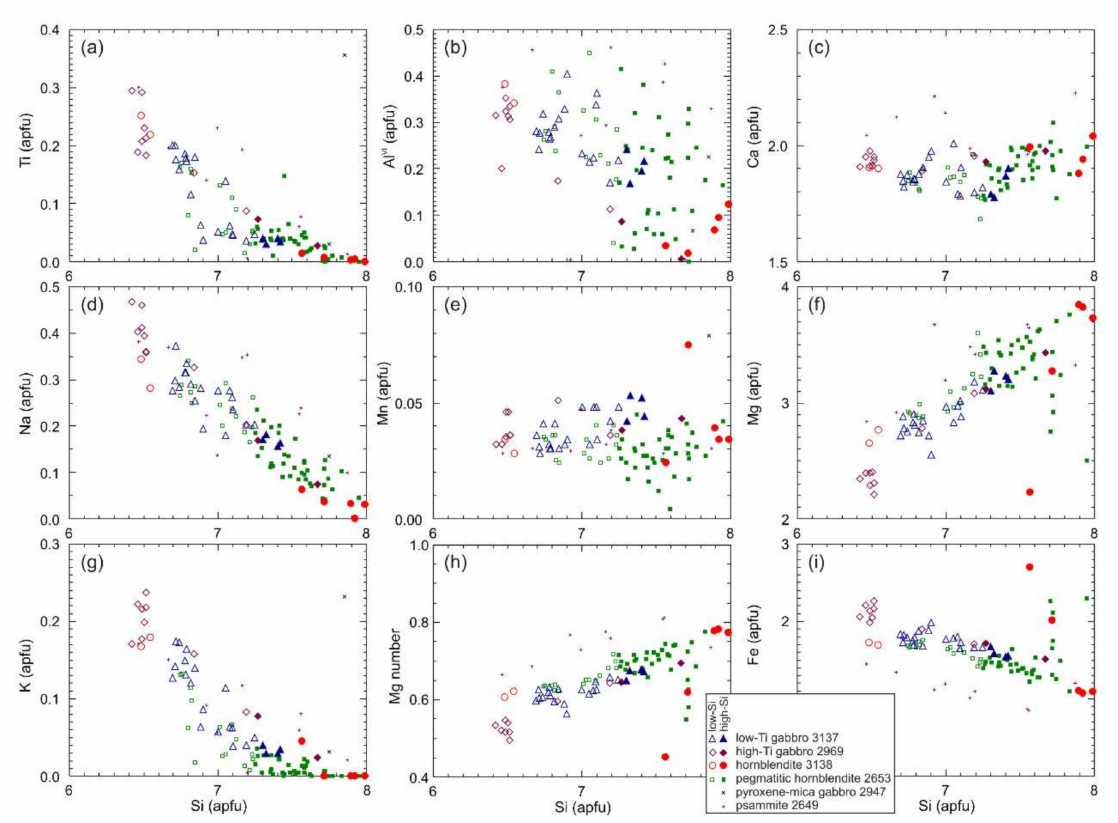
Figure 3. Cation variations with Si for the analysed amphiboles (based on 23 oxygens). ( a ) is Ti; ( b ) is Al vi ; ( c ) is Ca; ( d ) is Na; ( e ) is Mn; ( f ) is Mg; ( g ) is K; ( h ) is Mg / (Mg + Fe); ( i ) is